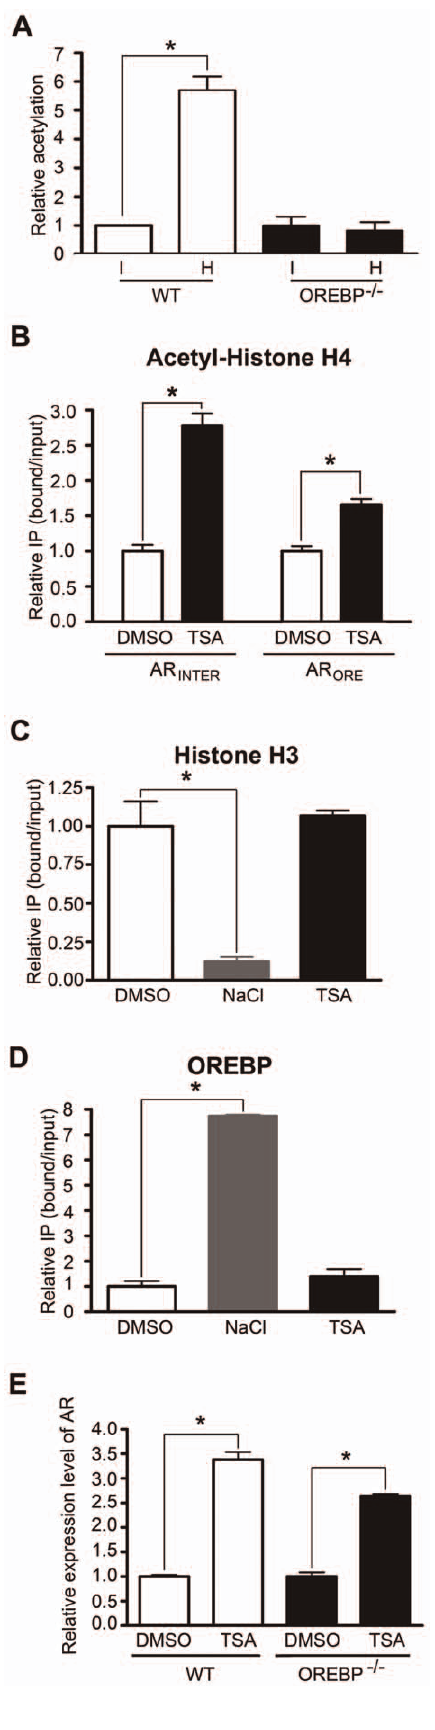
Figure 5. Association between OREBP, histone acetylation and histone eviction. (A) Role of OREBP in histone H4 acetylation. WT and OREBP 2 / 2 MEFs were maintained under isotonicity or treated with hypertonic medium for 1 h. ChIP was conducted with antibody against acetylated histone H4 and histone H4, respectively. DNA was analyzed by real-time PCR using AR ORE primer pair. The ratio of immunoprecip- itated DNA to total input DNA for each of the antibodies was determined. The value for acetylation histone H4 level was divided by H4 occupancy value. The value of WT MEFs under isotonic conditions was set to be 1.0. *, p , 0.001 by one-way ANOVA. I, isotonic medium; H, hypertonic medium. (B-E) Effect of TSA treatment on histone eviction at ORE and AR expression. WT MEFs were treated with DMSO or TSA (1 m g/ml) for 2 hr. ChIP was conducted with antibody against (B) acetylated histone H4, (C) histone H3, and (D) OREBP. In (B), DNA was analyzed by real-time PCR using AR ORE and AR INTER primer pairs. The ratio of immunoprecipitated DNA to total input DNA for each of the antibodies was determined. Values of DMSO treatment were set to be 1.0. *, p , 0.05 by one-way ANOVA. In (C) and (D), DNA was analyzed by real-time PCR using AR ORE primer pair. The ratio of immunoprecipitated DNA to total input DNA for each of the antibodies was determined. The results were normalized to the ratio of immunoprecipitated DNA to total input DNA of DMSO treatment. *, p , 0.01 by one-way ANOVA. (E) Quantitative analysis of AR transcriptions by RT-PCR. Cells were treated with DMSO or TSA (1 m g/ml) for 8 h. Total RNA was prepared and relative AR mRNA level was determined. The result was expressed as fold change relative to the expression level of WT MEFs treated with DMSO. Data are the mean 6 SEM (n=3). *, p , 0.001 by one-way